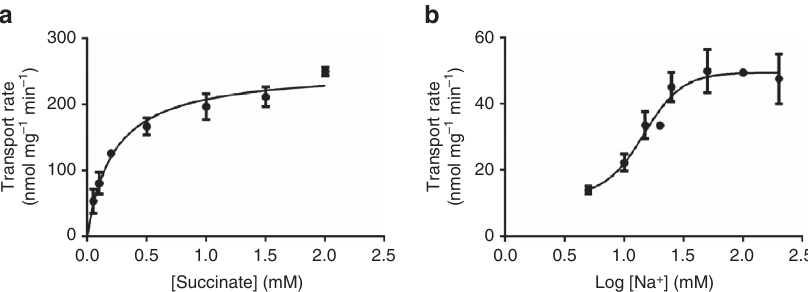
Figure 3 | Succinate transport activity of VcINDY. ( a ) The initial rates of succinate transport at 200mM external Na þ and pH 7.4 were plotted against external succinate concentrations. Data were averaged to fit to the Michaelis–Menten equation, yielding a K M of 0.22mM and a V max of 254nmolmg (cid:2) 1 min (cid:2) 1 , respectively. ( b ) The initial rates of succinate transport at 50 m M external substrate concentration ( B 20% of the measured K M ) and pH 7.4 were plotted against the common logarithm (Log) of external Na þ concentrations. Data were averaged to fit to the Hill equation, yielding a Hill coefficient of 2.7 and a K 0.5-Na of 14.6mM, respectively. The error bars represent s.d. from at least three independent experiments.